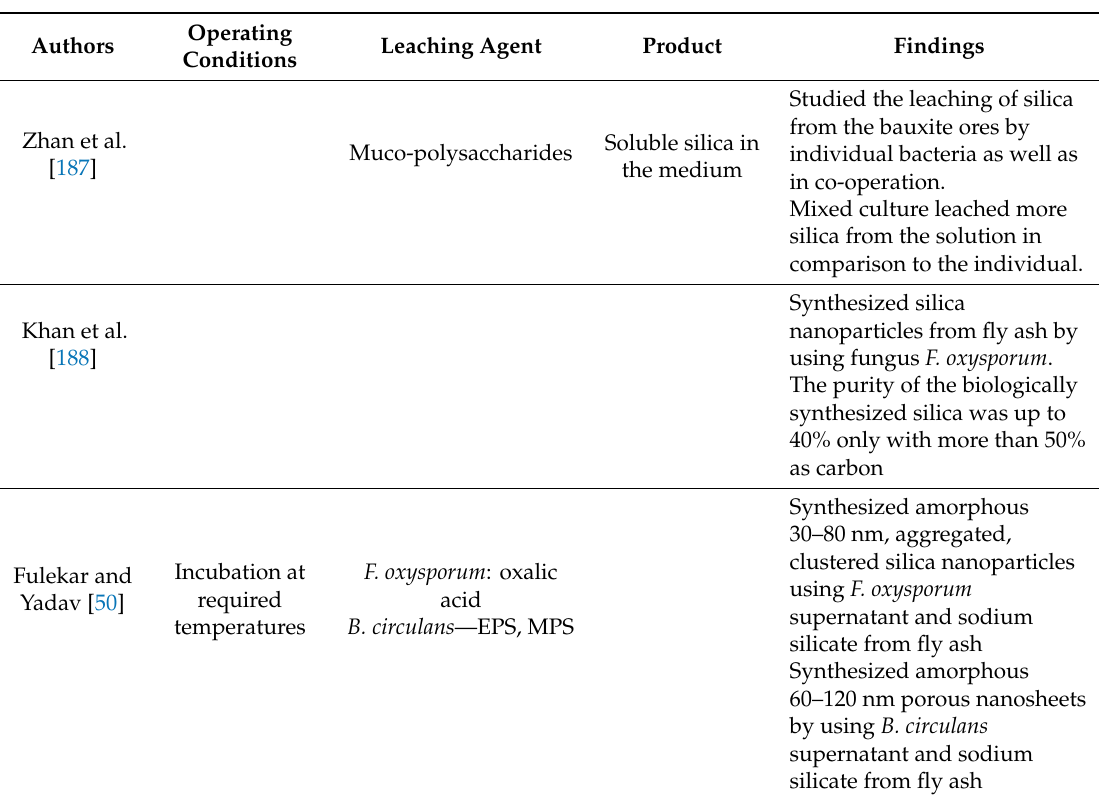
Table 7. Microbial leaching of silica and synthesis of SiNPs from fly